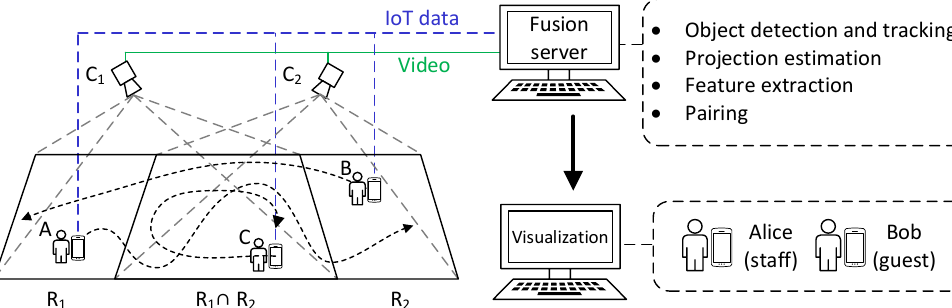
Figure 1. The device–object pairing system